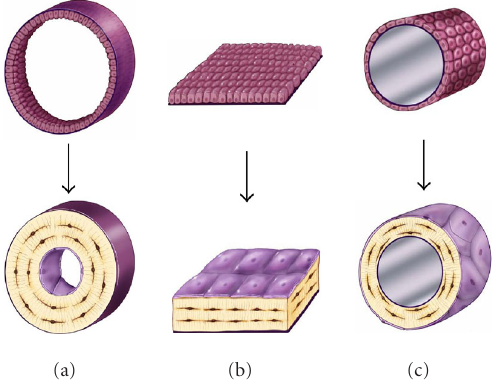
Figure 8. The e ff ect of surface geometry on the fate of 128 os- teoblasts. A cell-based model is shown representing bone forma- tion on three di ff erent surface geometries: (a) a concave segment of a 200 µ m diameter osteon in cortical bone, (b) a flat surface in cortical or cancellous bone, and (c) the convex surface of a 100 µ m diameter trabecula in cancellous bone. In each case, a set of 128 osteoblasts is shown at t = 0 as ∼ 12 . 5 µ cuboidal cells covering an appropriate segment of the bone surface. Be- low, the same surface and the new bone formed by this set of 128 osteoblasts are shown. In each case, some fraction of cells must become embedded in the matrix as osteocytes to maintain an appropriate osteocyte density and some osteoblasts must be retained as lining cells covering the remaining surface. Cells that are not required as osteocytes or lining cells are presumed to be lost through apoptosis. The probability of osteoblast transit into the osteocyte or lining cell population, and the probability of apoptosis are dependent on surface geometry, the density of os- teocytes in the matrix, and the thickness of the new bone that is formed at the